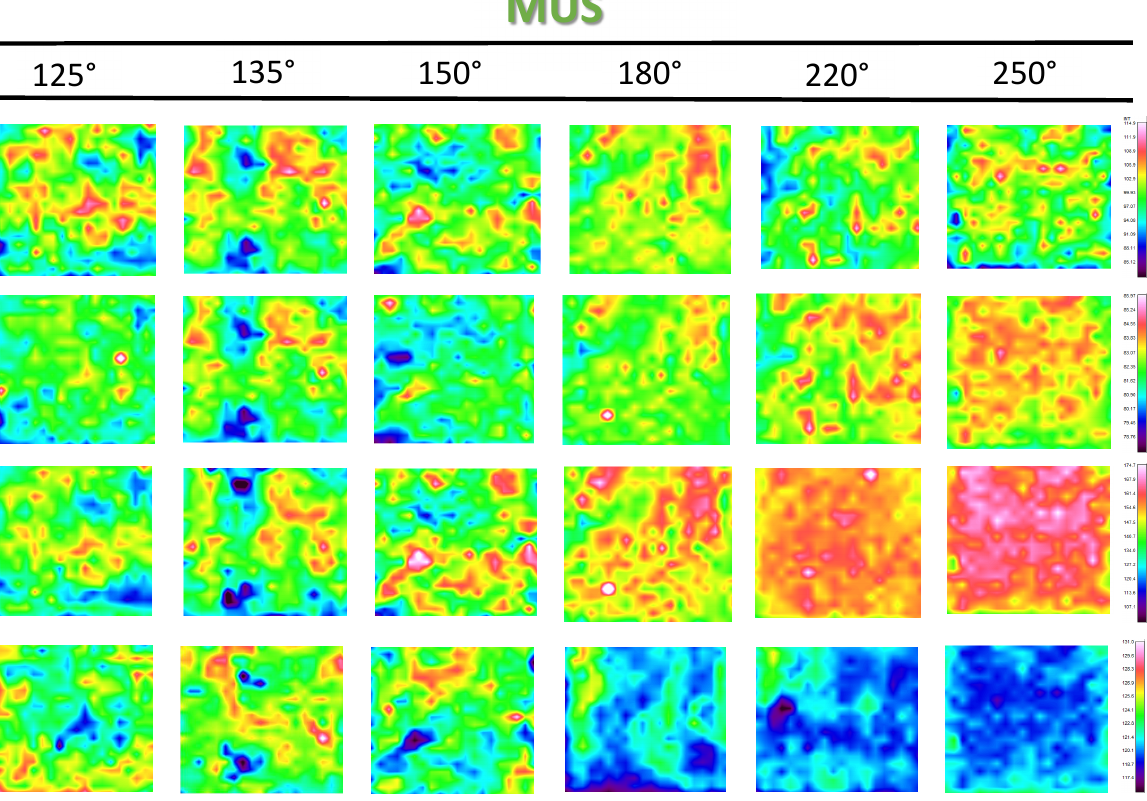
Figure 12. Raman spectroscopy surface maps of SMI/SfO-MUS coatings (1 × 1 mm 2 ), representing single band numbers for styrene, imide, oil, and cellulose (same intensity scale per